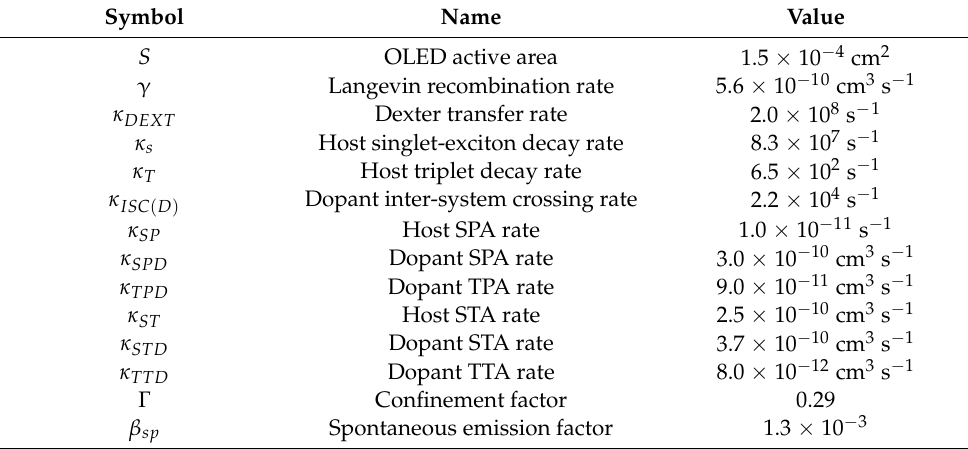
Table 2. Model Parameters for Figure